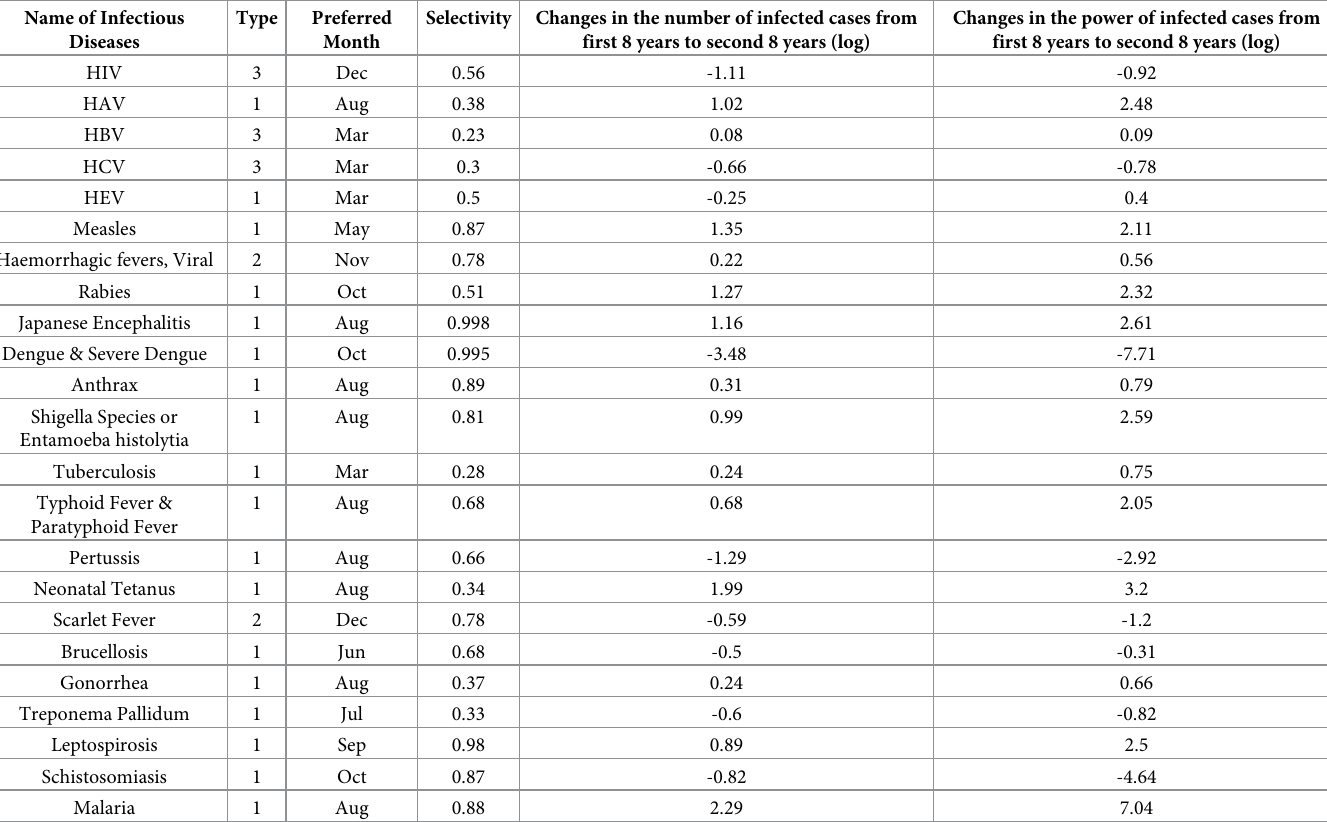
Table 1. Summary of the main finding in 23 infectious diseases in mainland China. Name of Infectious